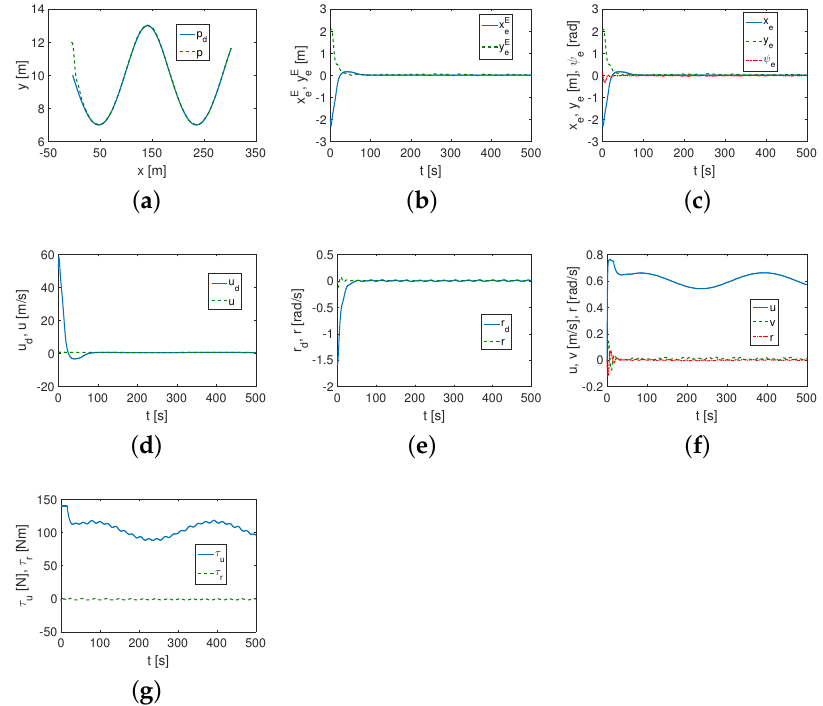
Figure 9. Simulation results for Kambara—IQV controller and cycloid trajectory (variable distur- bances): ( a ) desired and realized trajectory; ( b ) position errors (E-frame); ( c ) position errors (B-frame) and angular error; ( d ) desired and realized velocity ( u d , u ); ( e ) desired and realized velocity ( r d , r ); ( f ) realized velocities; ( g ) applied force and torque.